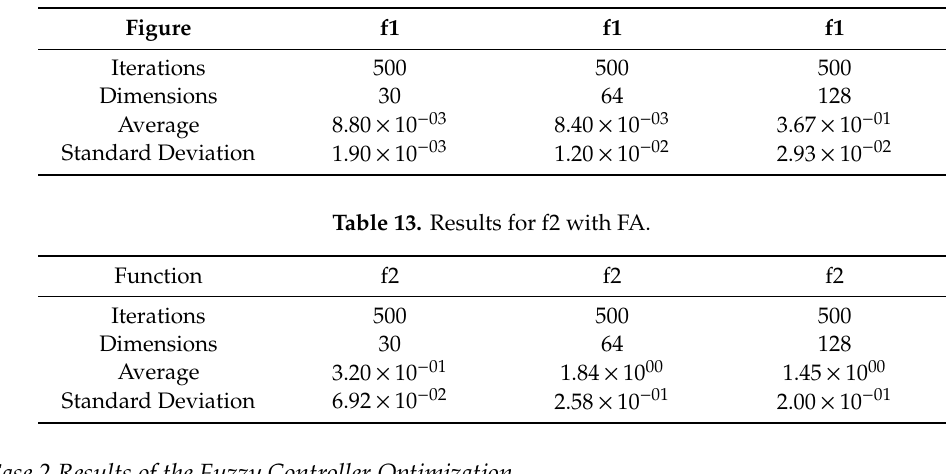
Table 12. Results for f1 with FA.